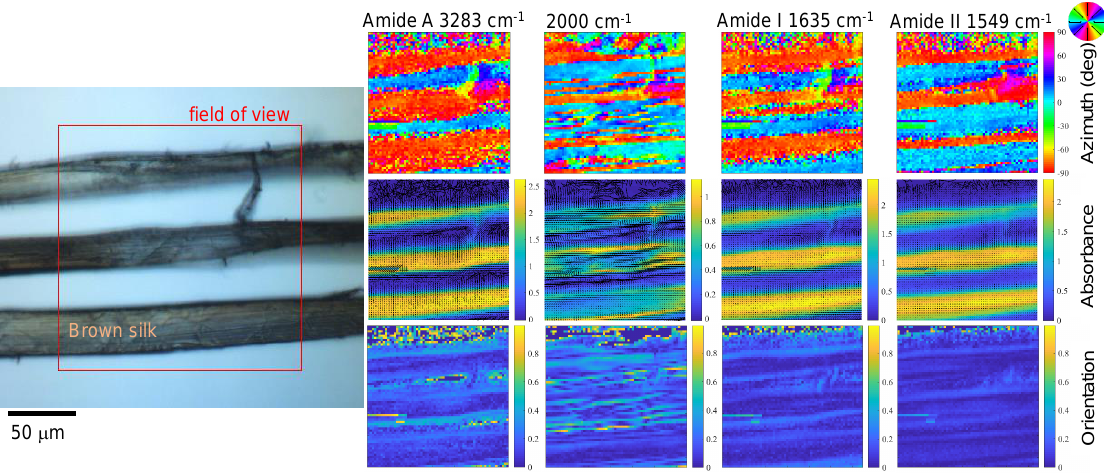
Figure A1. Optical image of brown silk fibres and maps of azimuth, absorbance, and orientation function. Light source was